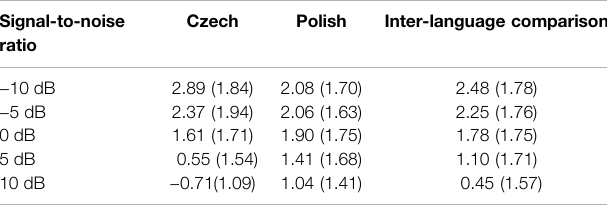
TABLE4| Meand-primevaluesforeachsignal-to-noiselevelineachexperimental block and the inter-language comparison (SD in brackets). Signal-to-noise